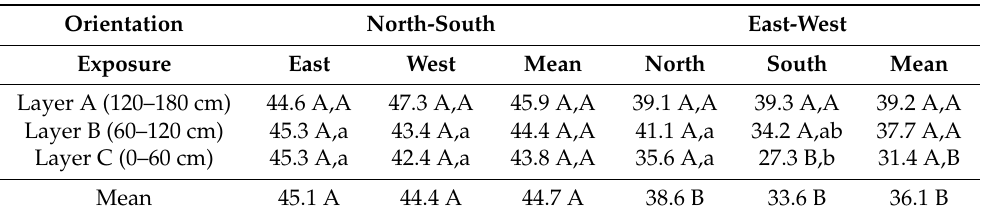
Table 1. Mean total number of buds per shoot (TB). The first letters denote significant differences between layers for a given exposure; the second letters denote significant differences between exposures for a given layer (SNK test). Lower case letters denote statistical differences with p = 0.05. Capital letters denote statistical differences with p =